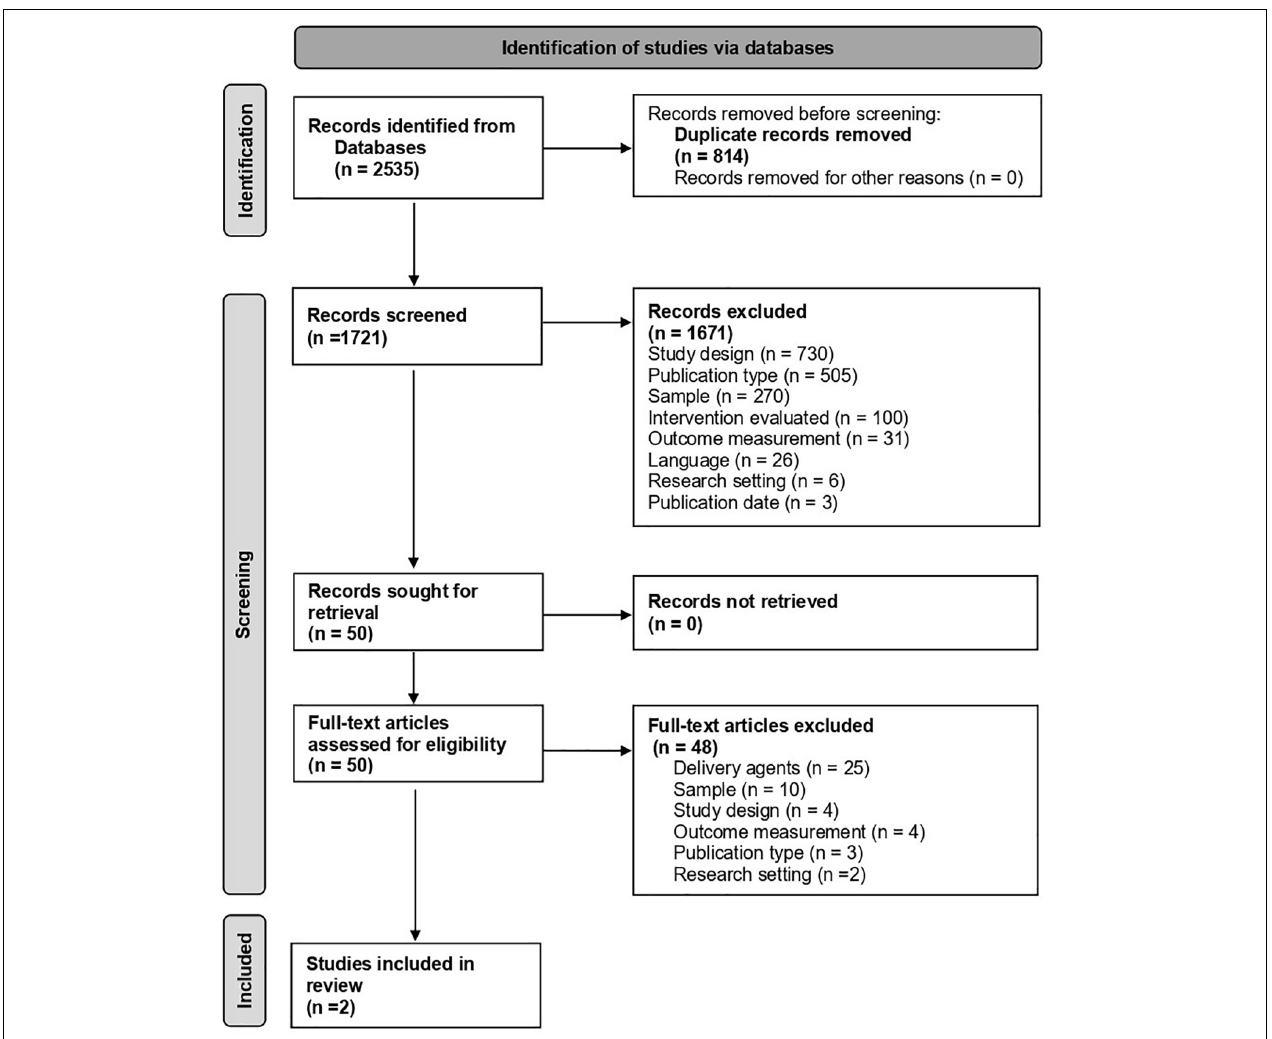
FIGURE 1 | PRISMA flow diagram of the study selction